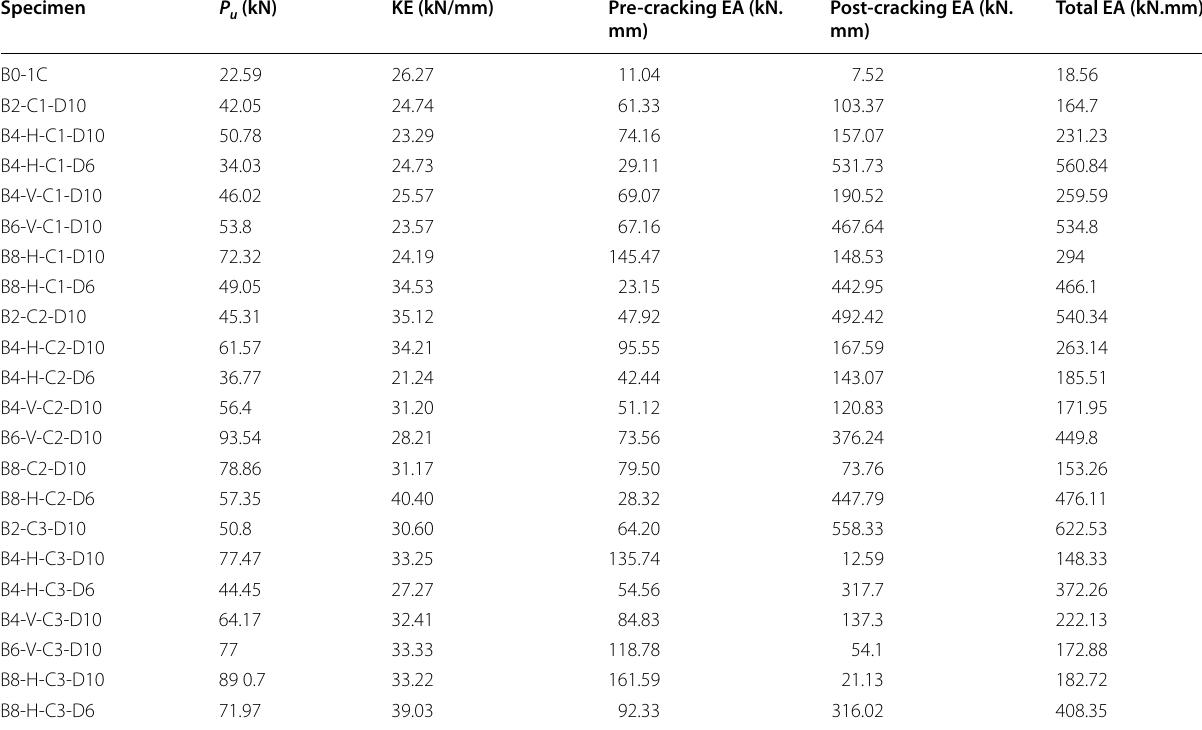
Table 4 Results of ultimate load, elastic stiffness and energy absorption of beams strengthened with bolt-glass fiber polymer composites (BGFPC)